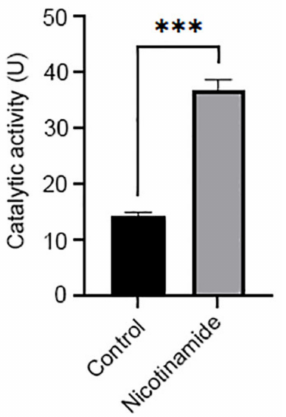
Figure 3. Effect of increased nicotinamide concentration upon NNMT activity in HepG2 hepatocarci- noma cells. Cells were incubated in cell culture media (control) or media supplemented with 100 µ M nicotinamide (nicotinamide) for 24 h. Cells were harvested, supernatant prepared and NNMT activity assayed. Results were calculated and expressed as nmol 1-methylnicotinamide produced/hr/mg protein ± S.D. Statistical analysis comprised Student’s t -test with Welch correction ( n = 3). *** = p <